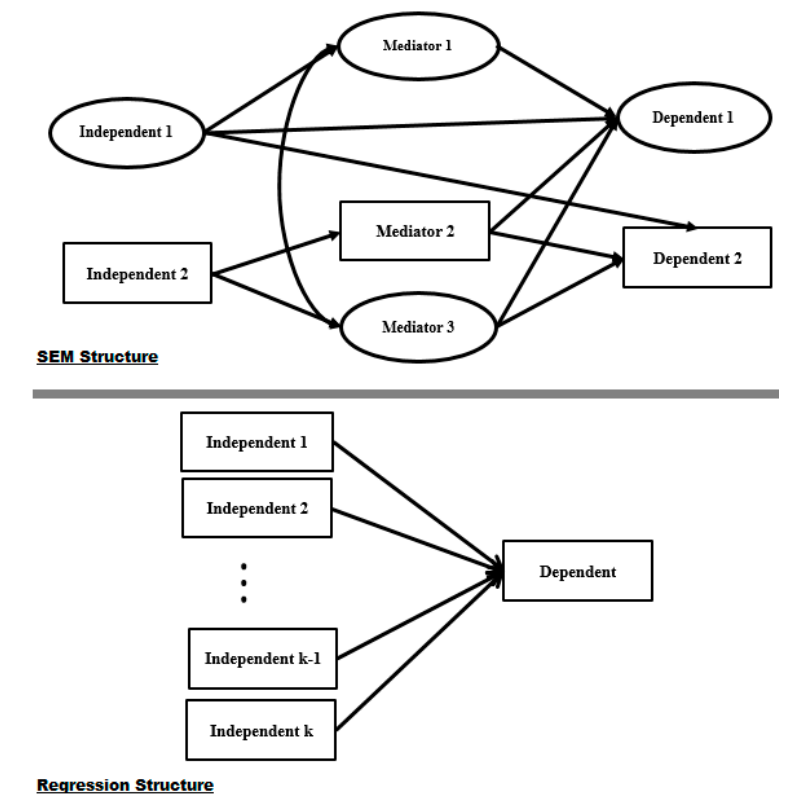
Figure 8. SEM and regression structures.